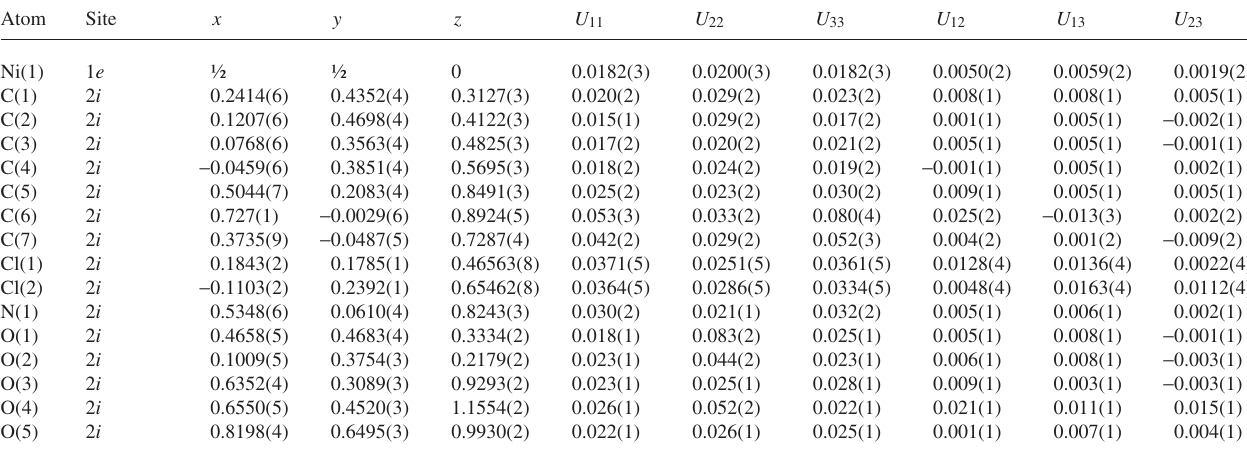
Table 3. Atomic coordinates and displacement parameters (in Å 2 )